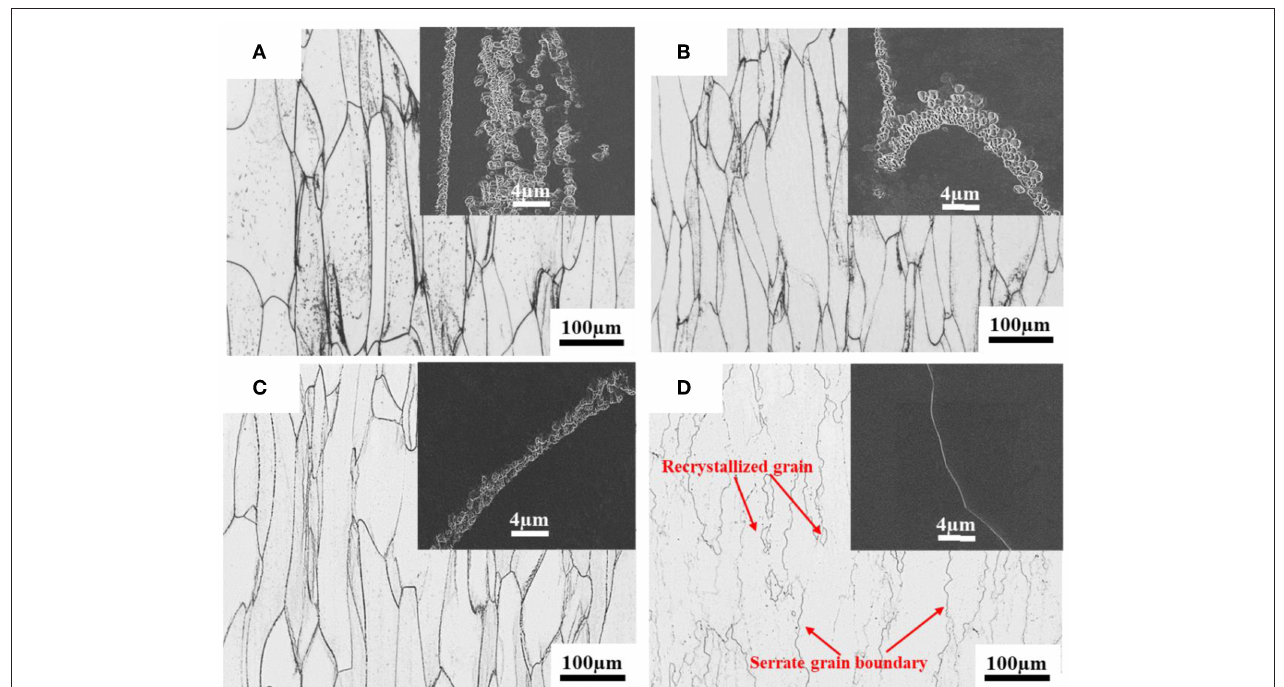
FIGURE 5 | Microstructure after isothermal compression under the strain rate of 10 − 3 s − 1 with different temperatures of (A) 605 ◦ C, (B) 655 ◦ C, (C) 705 ◦ C, (D) 755 ◦ C, and the upper right corners are the SEM images of the grain boundary at the corresponding temperature.